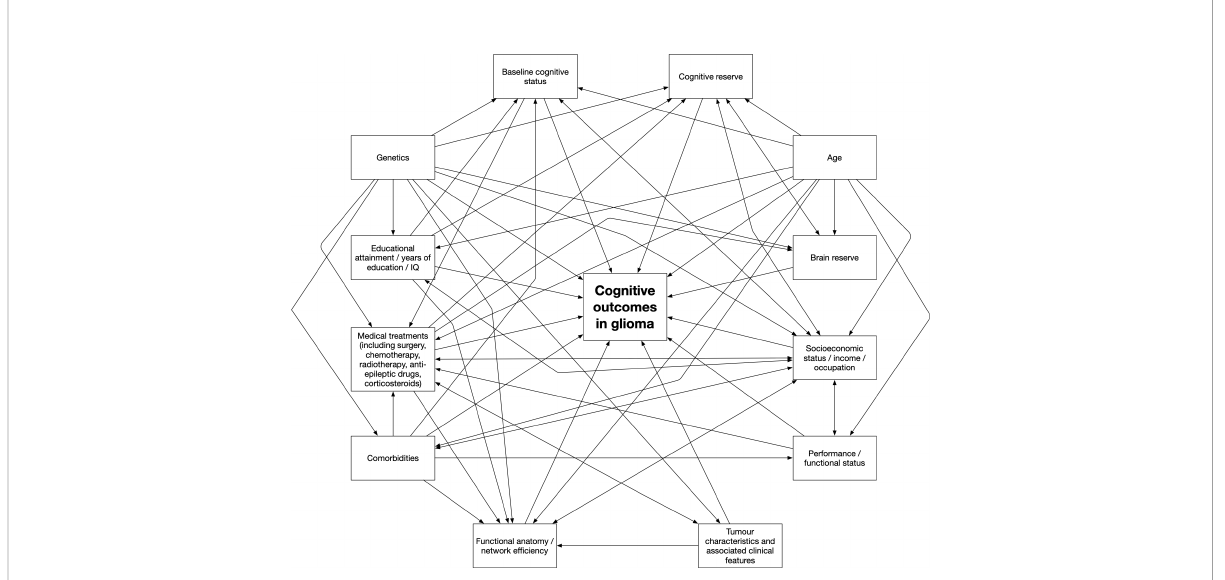
FIGURE 3 A proposed theoretical causal depiction of putative pathways related to cognitive outcomes in patients with